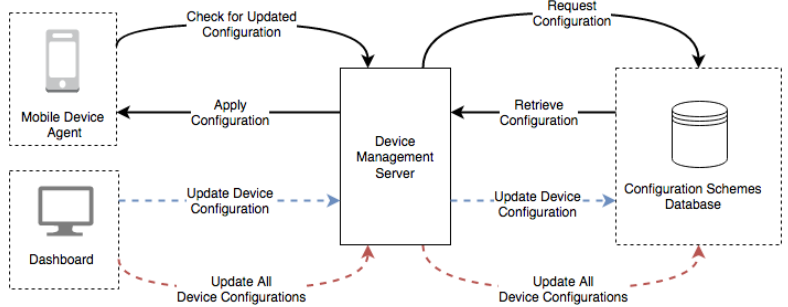
Figure 4. Device/agent